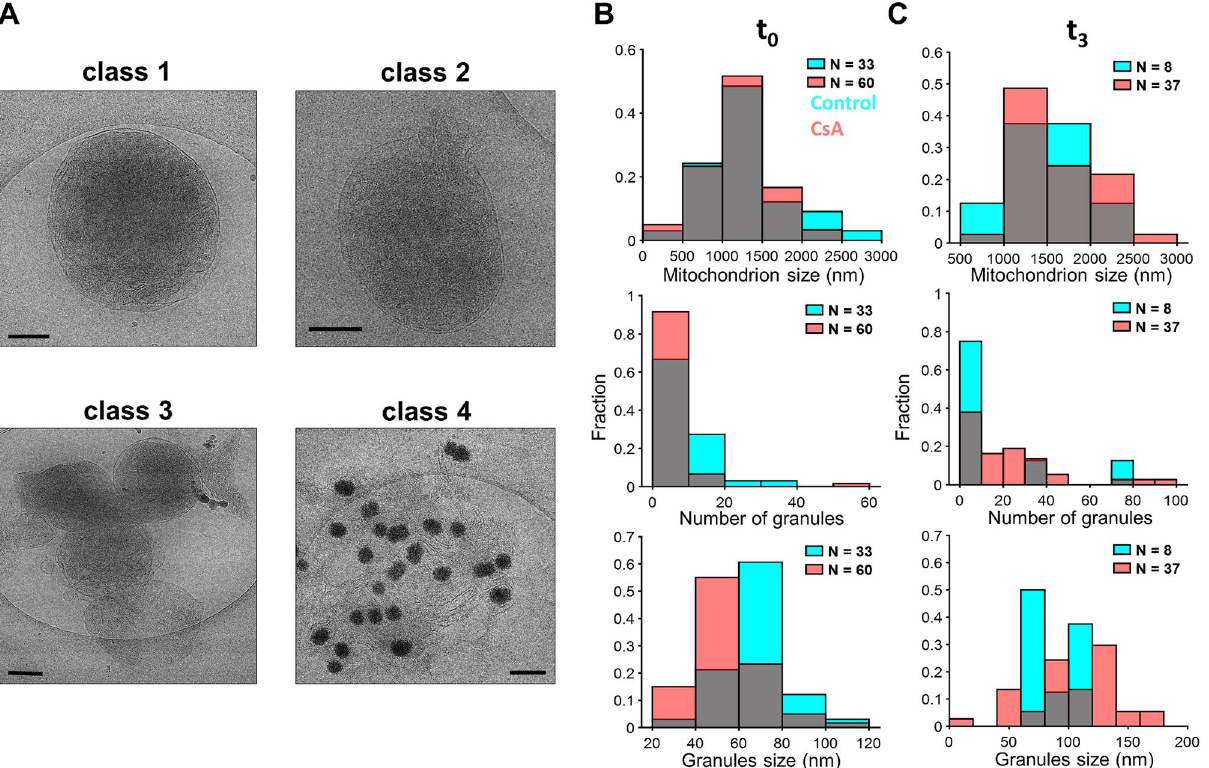
Figure 5. CsA disrupts OMM morphology, causes IMM release, and enhances the number and size of granules. Representative images before the addition of a 75 µM calcium bolus (t 0 ) in the presence of 1 µM CsA. Mitochondria were energized with 5 mM sodium pyruvate and 1 mM L-malate. ( A ) CsA induced morphological changes to mitochondria that can be grouped into 4 classes as described in Supplementary Table 2. ( B ) The mitochondrial size, calcium phosphate granules size and number per mitochondrion were quantified for each time-point (t 0 –t 3 ) before and after the addition of a 75 µM calcium bolus in the presence or absence of CsA. ( B ) There are no differences in the mitochondrial size of control to CsA-treated mitochondria before the addition of calcium. ( C ) After the calcium addition, the number and size of the granules increased in CsA-treated mitochondria were much larger than in the control mitochondria. Scale bars are 250 nm. n represents the number of images analyzed by the time point for control and CsA treated conditions. Gray zones represent the overlapping points between